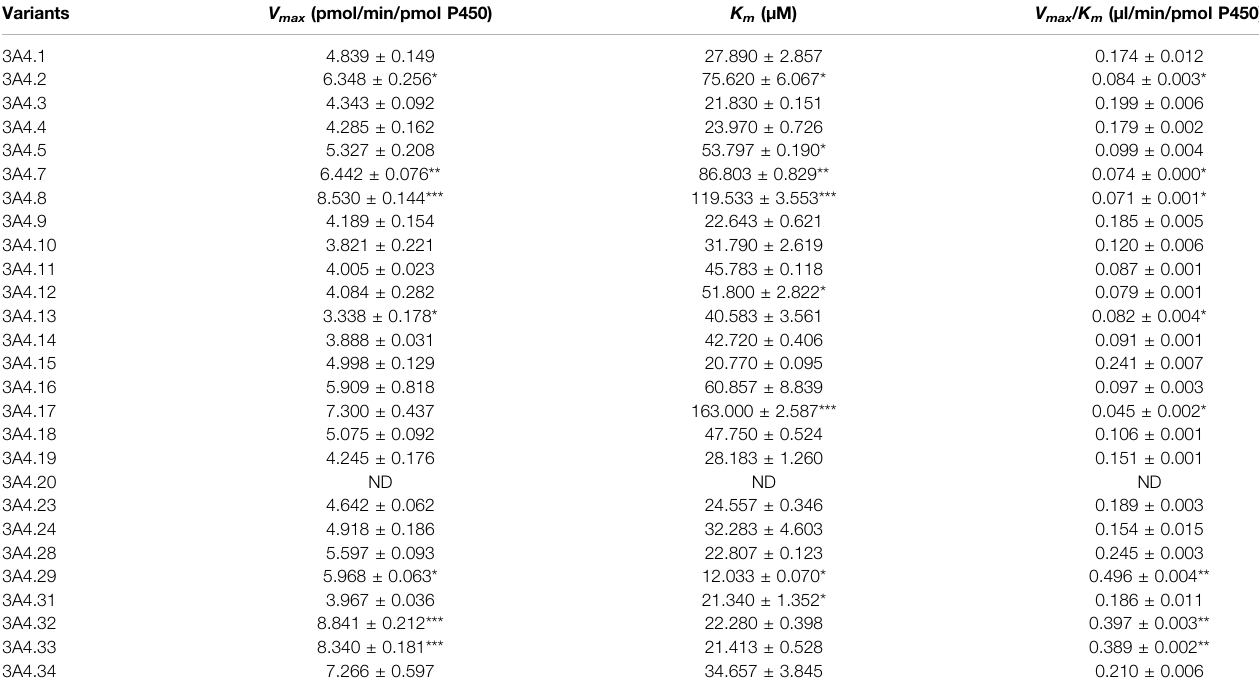
TABLE 1 | Kinetic parameters for AZ5104 activity of CYP3A4.1 and other CYP3A4 variants in osimertinib metabolism. Variants